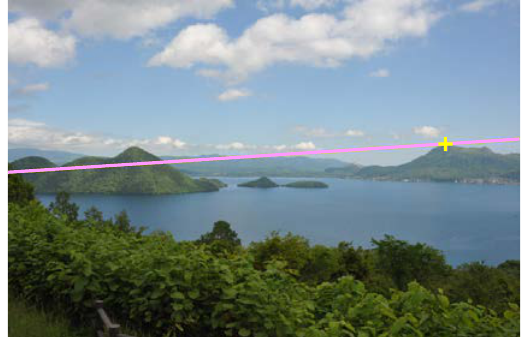
Figure 7. ImageA and measurement result